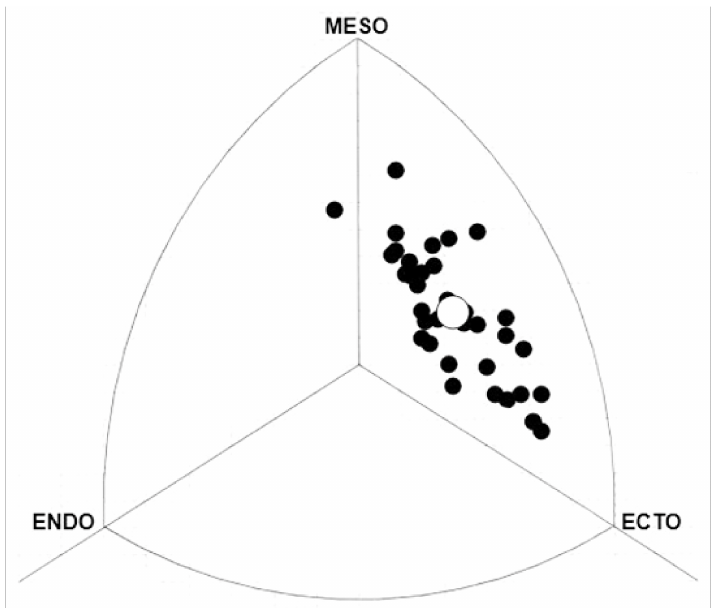
Figure 1. Somatotype distribution seen in young elite runners (n = 90). O = mean somatotype = 1.7-3.8-3.8 (endomorph, mesomorph,